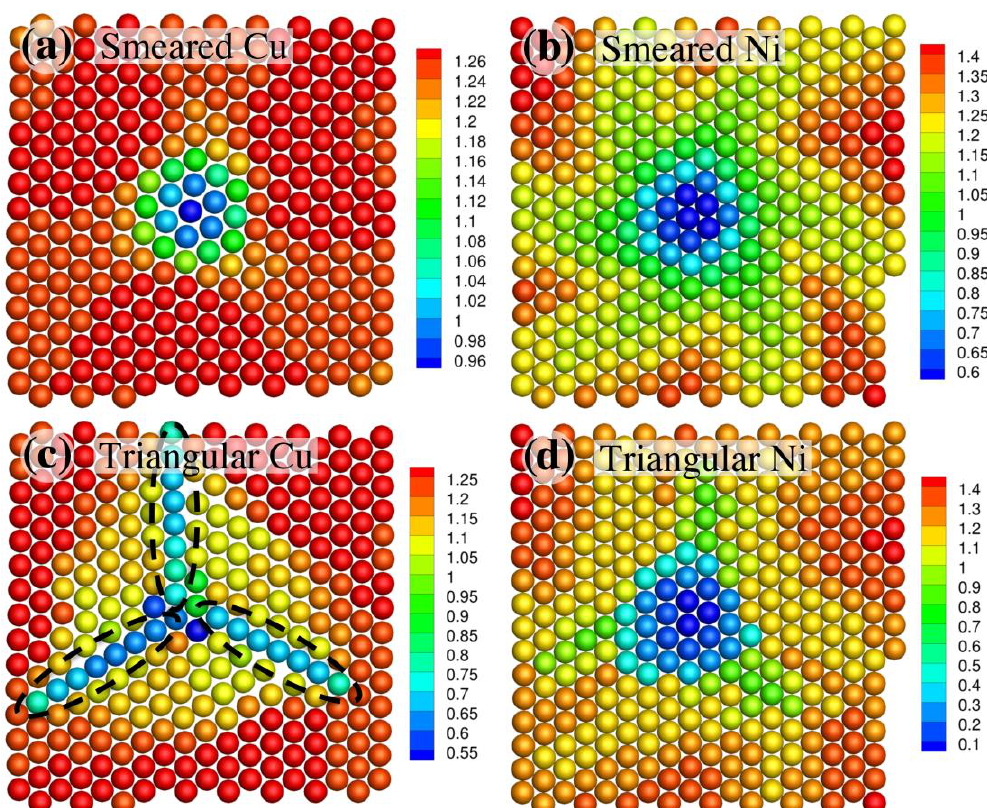
Figure 6. Mechanisms for lattice dislocation nucleation from the volume condensed nodes with triangular ( a , c ) and hexagonal ( b , d ) dislocation patterns. In ( a , b ), the nucleation sites for the lattice dislocations are marked by the red shaded areas; ( c , d ) show the dislocation configuration at nodes after the nucleation of